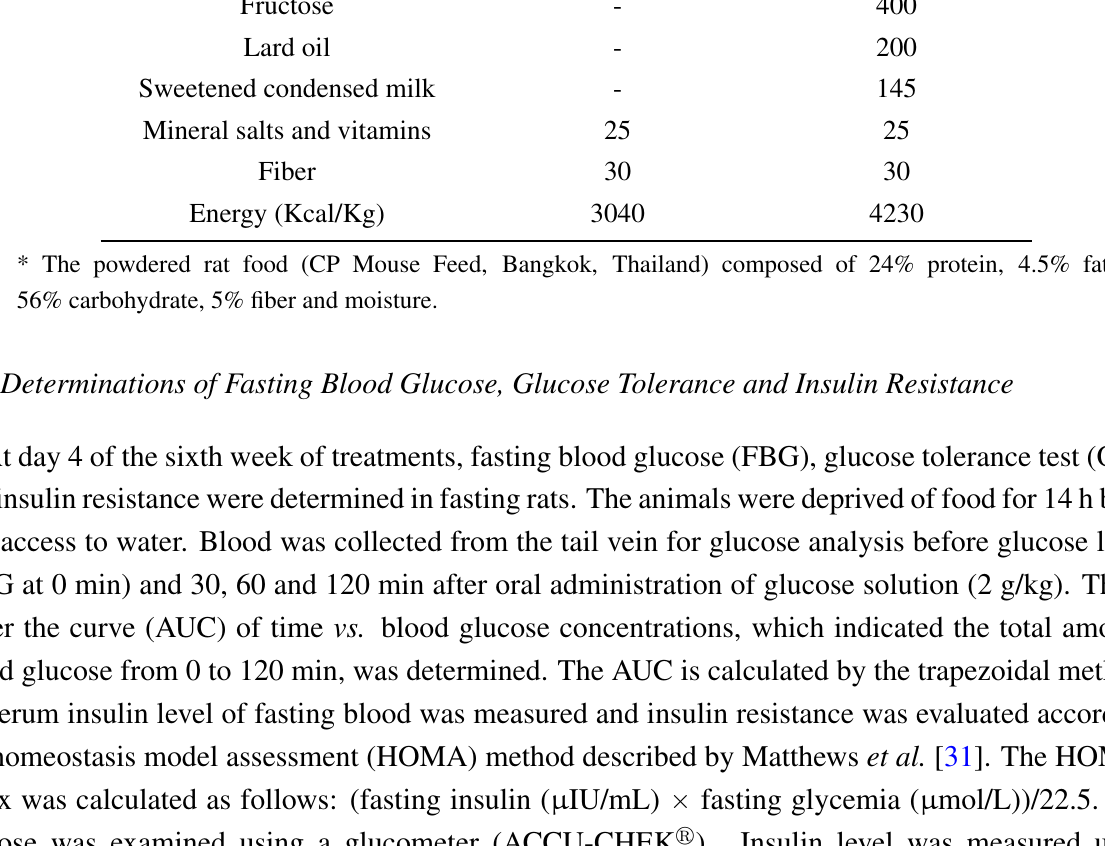
Table 1. Composition of normal- and high-carbohydrate and high-fat diets. Compositions Normal Chow (g/Kg) HCHF Diet (g/Kg) Powdered rat food * 945 200 Fructose - 400 Lard oil - 200 Sweetened condensed milk - 145 Mineral salts and vitamins 25 25 Fiber 30 30 Energy (Kcal/Kg) 3040